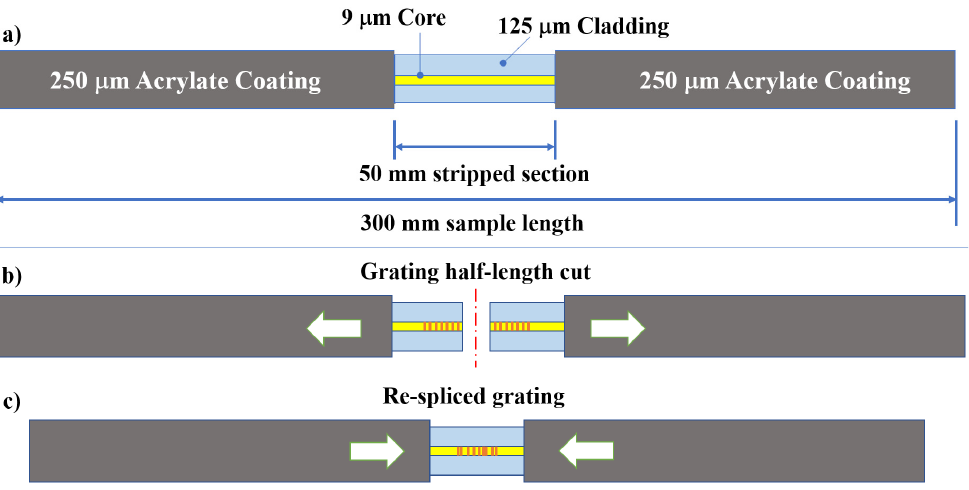
Figure 1. Specimens’ configuration. ( a ) The so-called “dummy sample” consists of a 9/125 bare fiber segment; ( b ) the sample carrying the Bragg grating was first cut at its half-length and then ( c ) re-spliced.